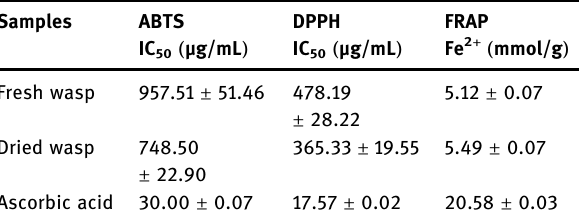
Table 1: Antioxidant activities of the V. auraria extracts ( x ± s , n = 3 )